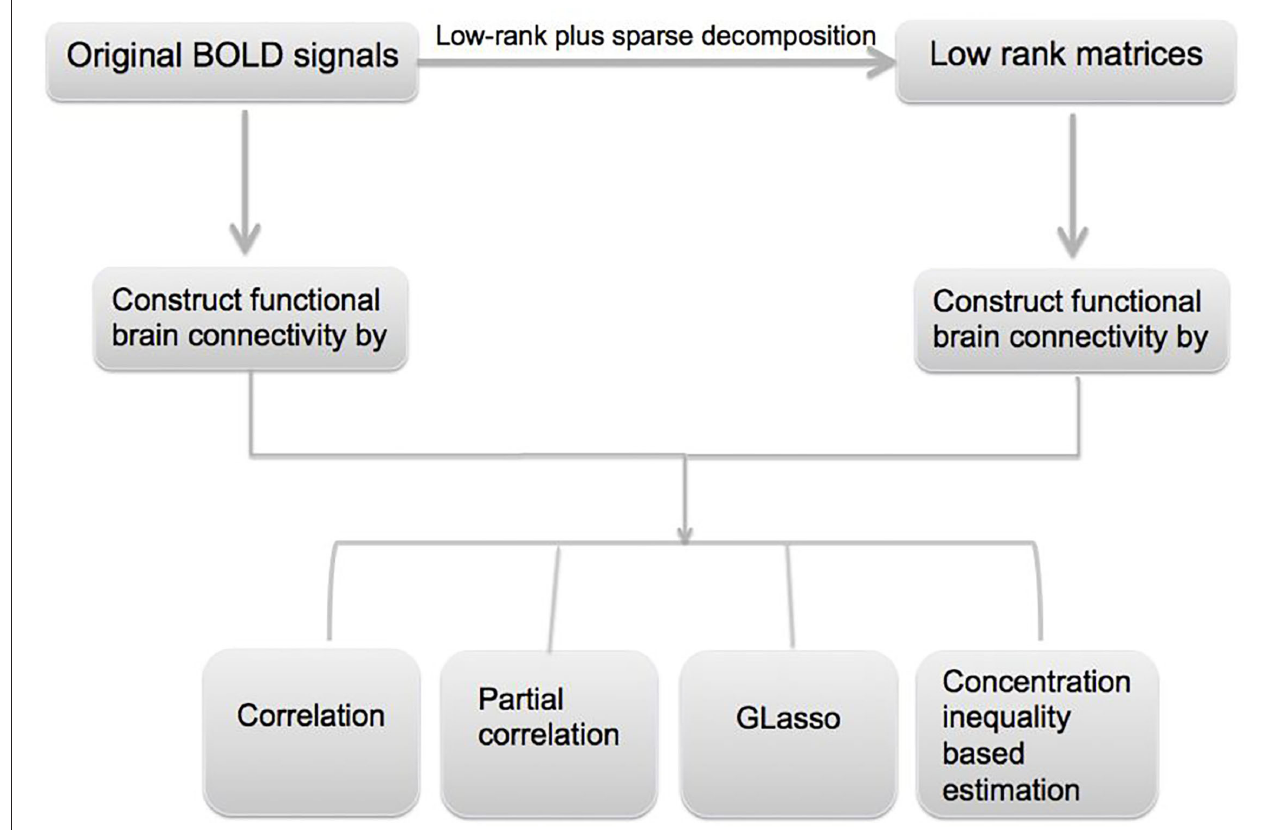
FIGURE 1 | Flowchart for the proposed robust functional brain connectivity